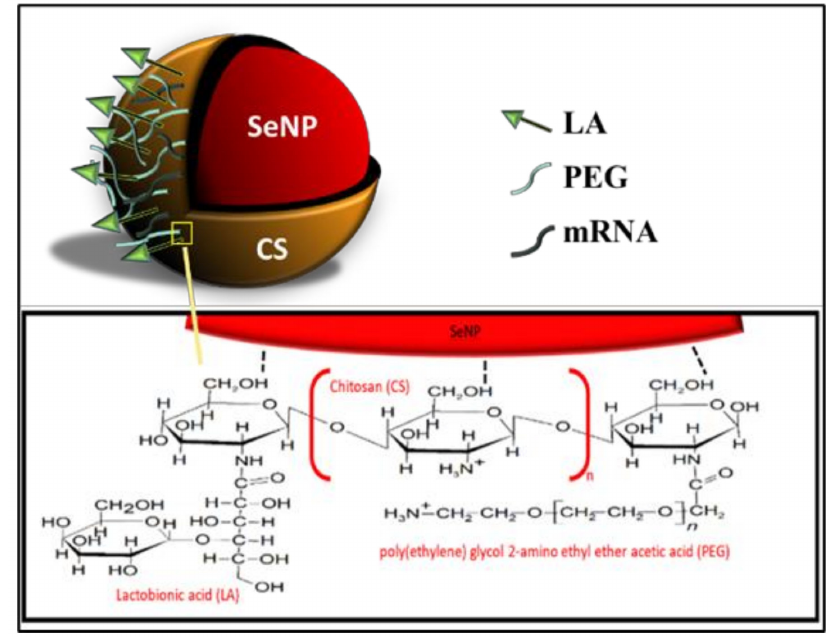
Figure 2. An illustration of the fully functionalized SeNP.